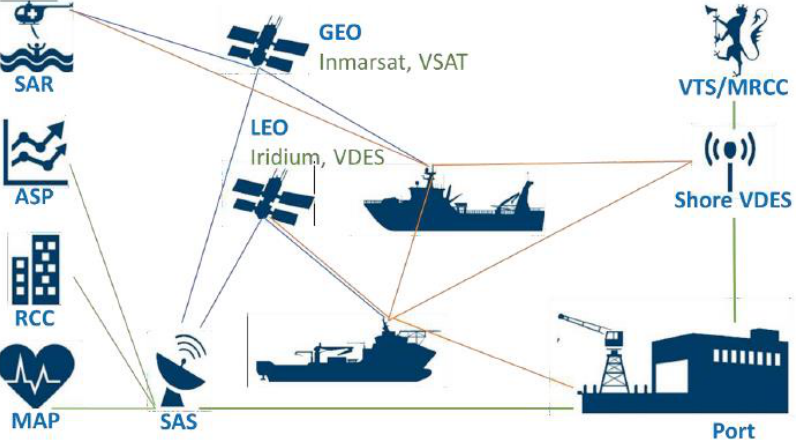
Figure 26. Communication system between autonomous ships and other maritime entities, including the port infrastructure. Reprinted from ref. [122].